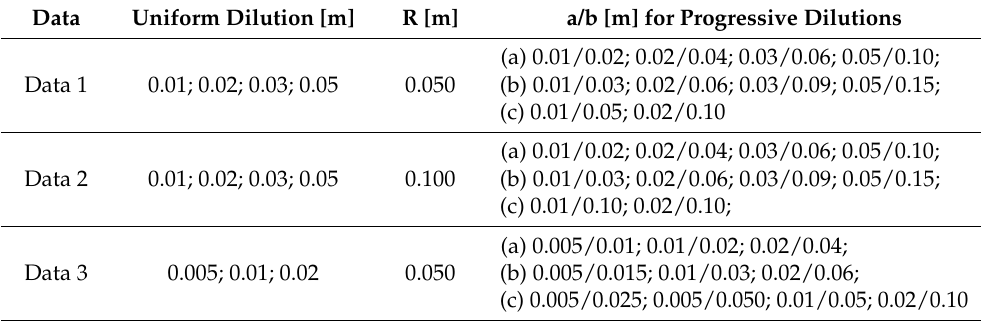
Table 1. The minimum distances of neighboring points used for dilution and testing.